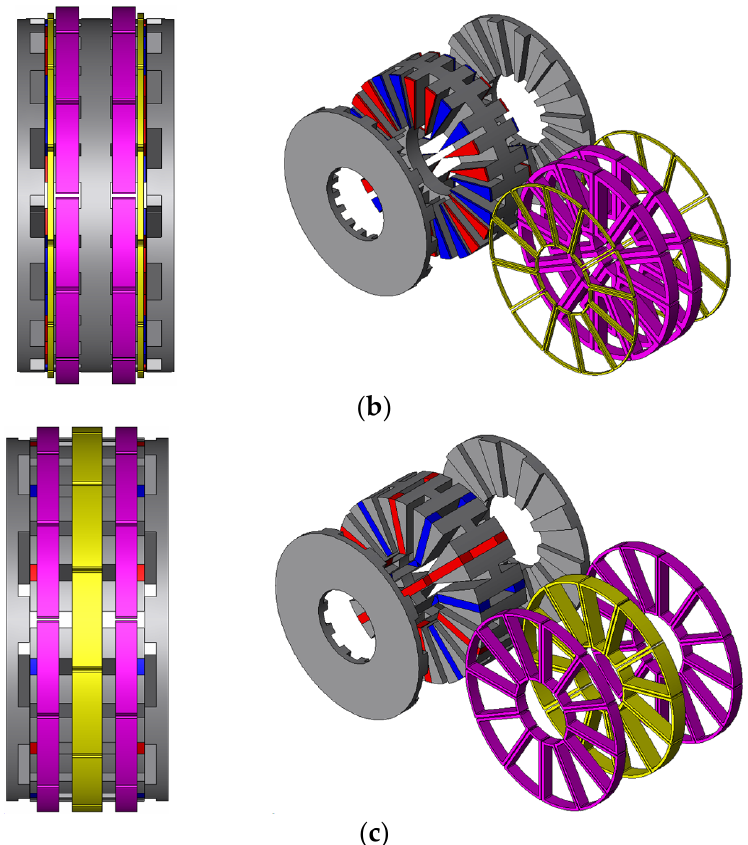
Figure 1. Topologies and 3D exploded views of three AF-DR motors: ( a ) DSPM, ( b ) FRPM, ( c ) FSPM.